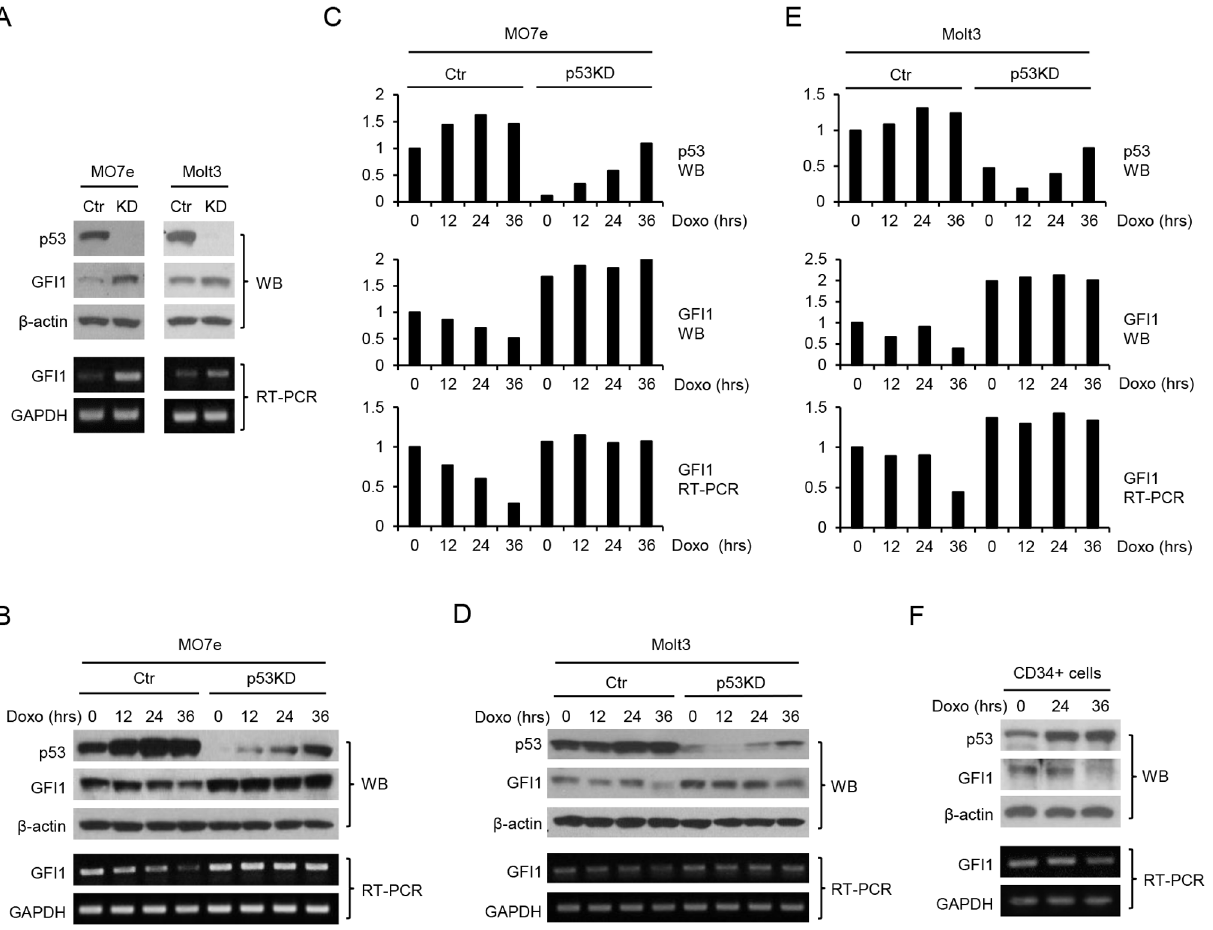
Figure 1. GFI1 protein and mRNA levels are upregulated upon p53 knockdown. (A) MO7e and Molt3 cells were infected with the lentivirus containing a p53 shRNA. The expression of GFI1 and p53 proteins was examined by Western blot analysis. GFI1 mRNA levels were examined by RT- PCR. Subsequently, control (Ctr) and p53 knocked down (KD) MO7e (B) and Molt3 (D) cells were treated with Doxo (25 ng/ml) for times as indicated and examined for expression of p53 and GFI1. The results shown in B and D were quantitated using ImageJ and normalized based on the levels of b - actin protein and GAPDH mRNA for MO7e (C) and Molt3 (E) cells. (F) Human umbilical cord blood CD34 + cells were treated with Doxo prior to evaluation of the expression of p53 and GFI1.